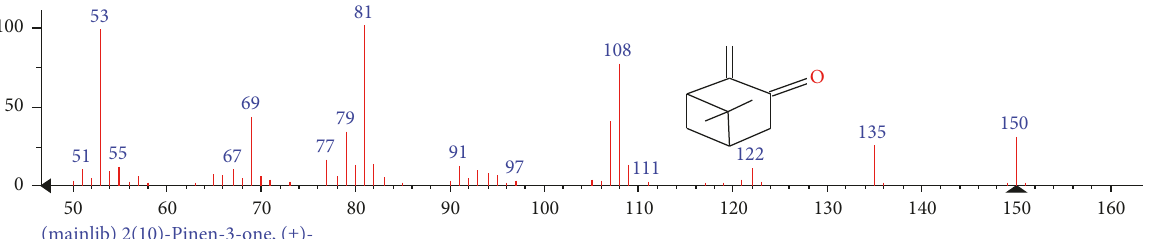
Figure 12: Mass spectrum of compound 2(10)-pinen-3-one of whole plant hexane fraction of Achillea wilhelmsii (WHFAW).